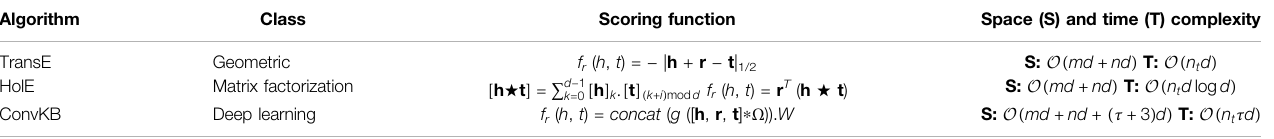
TABLE 4 | Details of selected KGE algorithms: class of algorithm, triple scoring functions and their space and time complexities. Notation used : m (cid:2) | N | , n (cid:2) | R | , n t (cid:2) # of training triples, h , r , t ∈ R d , τ (cid:2) | Ω | (cid:2) # of convolution fi lters. Algorithm Class Scoring function Space (S) and time (T)